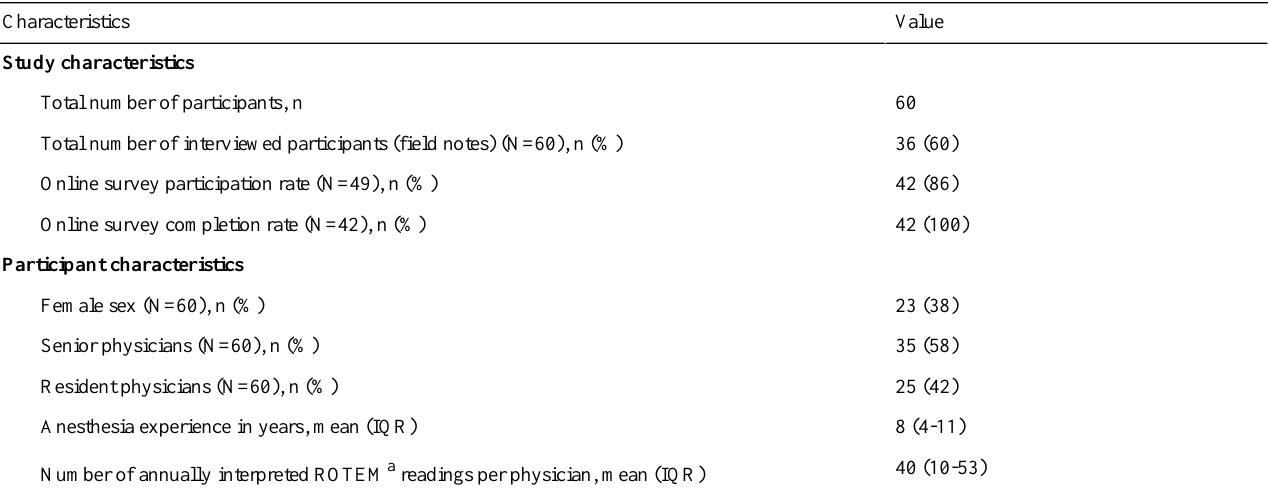
Table 1. Study and participant